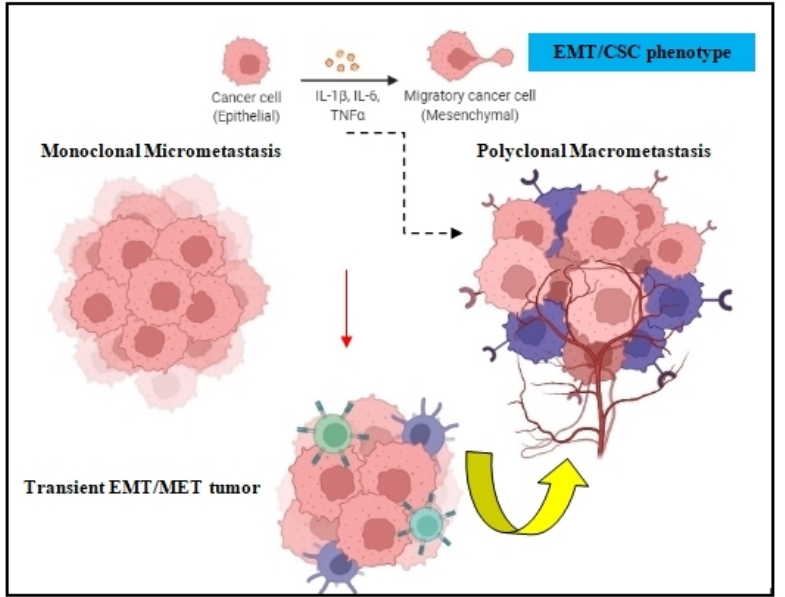
Figure 2. EMT in tumor cell dissemination. The EMT/CSC phenotype of DTCs can prompt monoclonal micrometastasis seeding to develop polyclonal macrometastasis, depending on the clonal and tumor ‐ stromal cells interactions in the target organ.